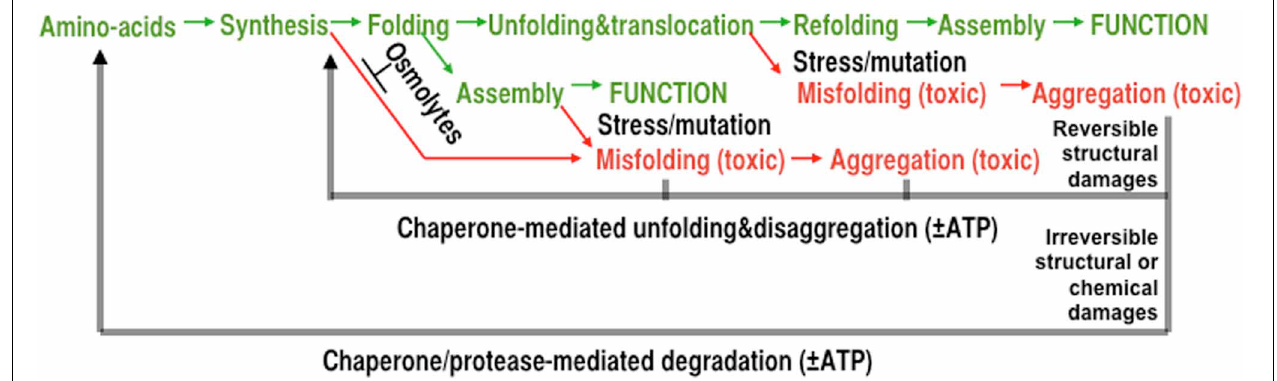
FIGURE 1 | The various mechanisms of protein homeostasis. The maturation process of a polypeptide, from synthesis to the assembly of a native functional oligomer (green) is composed from delicate successive processes that can be affected by mutations, chemical modifications, and stress. Under stressful conditions, polypeptides may convert into misfolded and increasingly insoluble aggregates lacking specific biological activities.